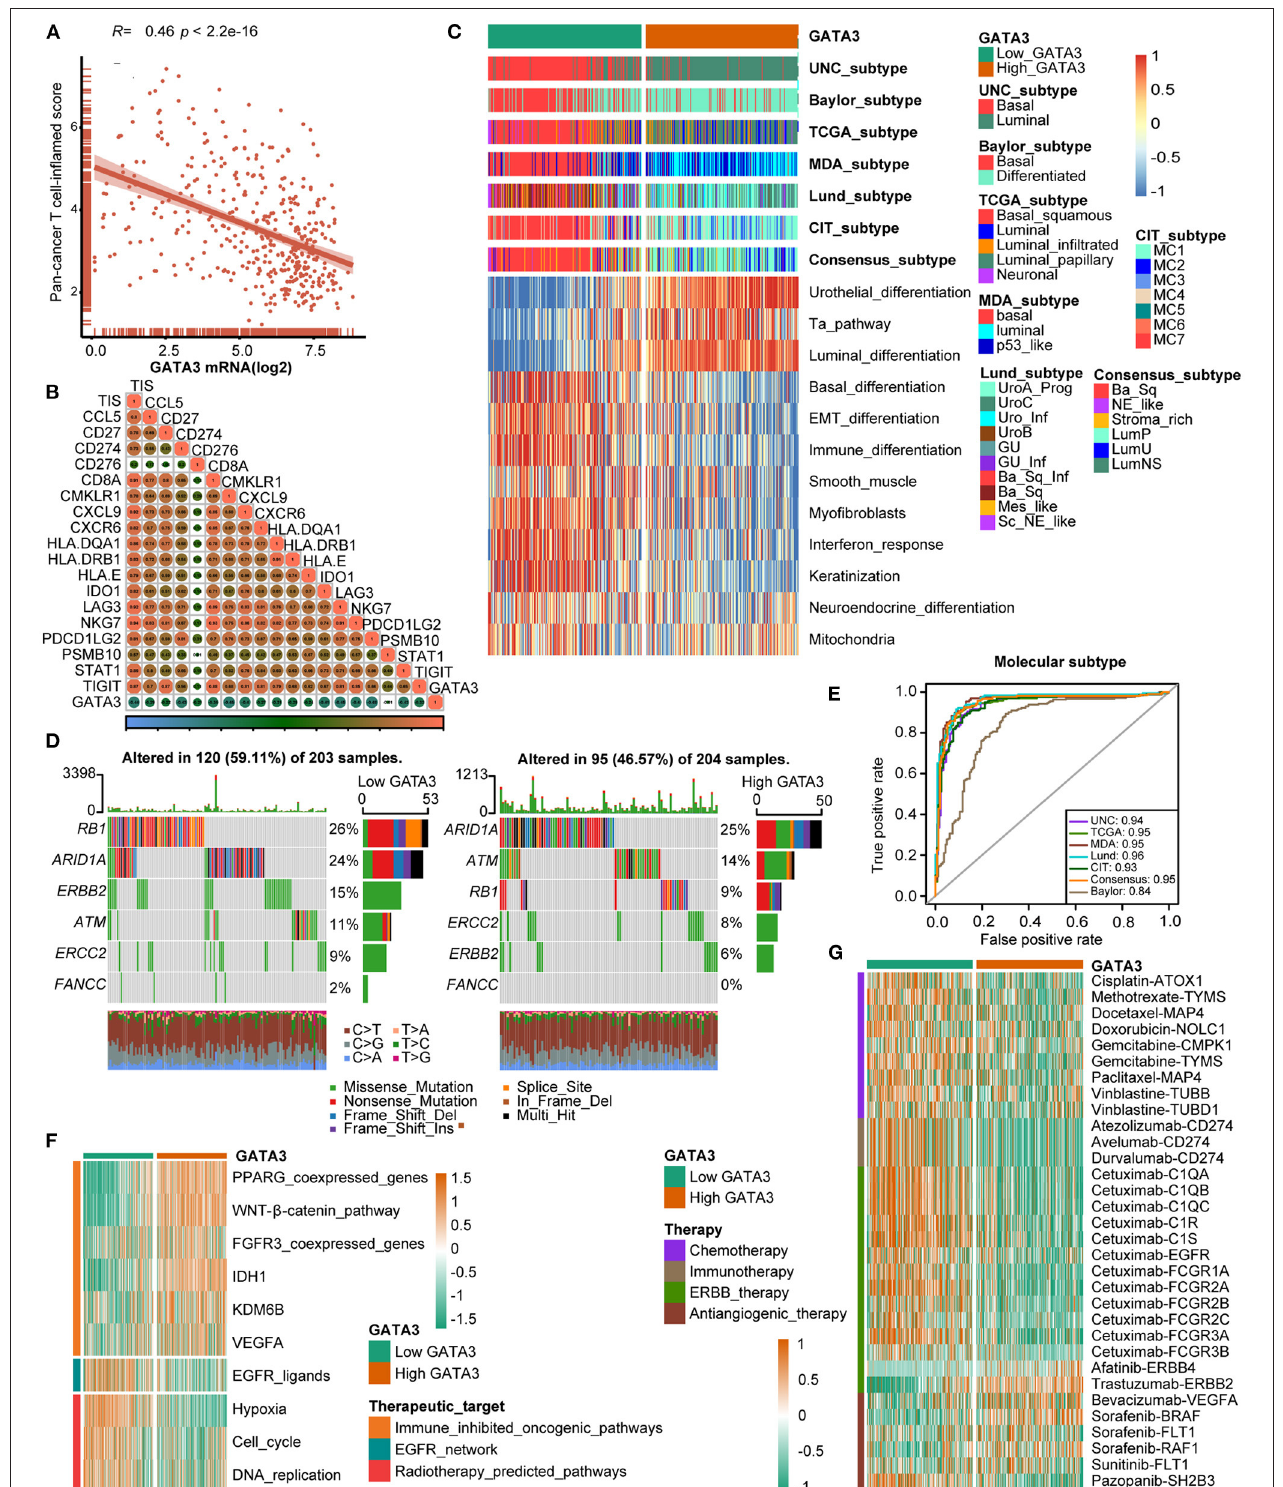
FIGURE 4 | GATA3 predicts the molecular subtype and response to several therapies in BLCA. (A,B) Correlation between GATA3 with TIS and the corresponding TIS-related effector genes. (C) Correlations between GATA3 and molecular subtypes with seven different subtyping systems. (D,E) Mutational profiles of neoadjuvant chemotherapy-related genes in low- and high-GATA3 tissues. (E) ROC analysis on the prediction accuracy of GATA3 for molecular subtypes with different systems. (F) Correlation between GATA3 and the enrichment scores of therapeutic signatures. (G) Correlation between GATA3 and the drug-target genes of various therapies.